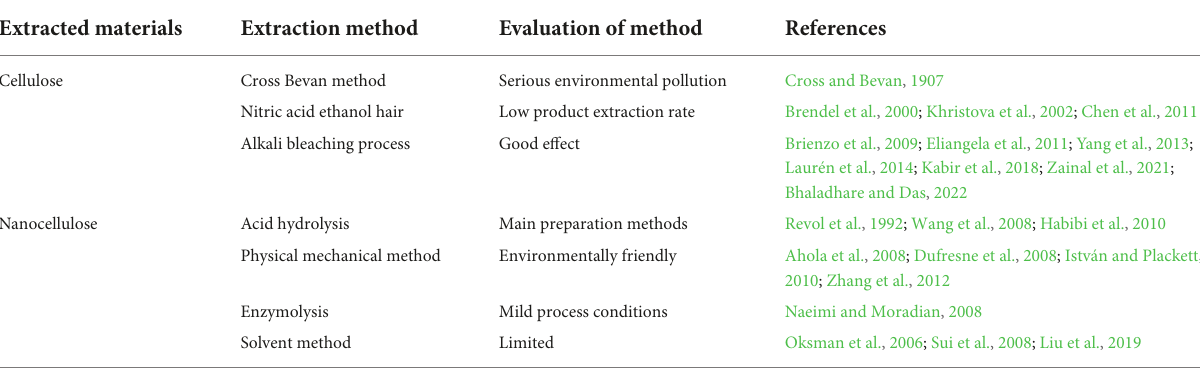
TABLE 1 Methods for extracting cellulose and